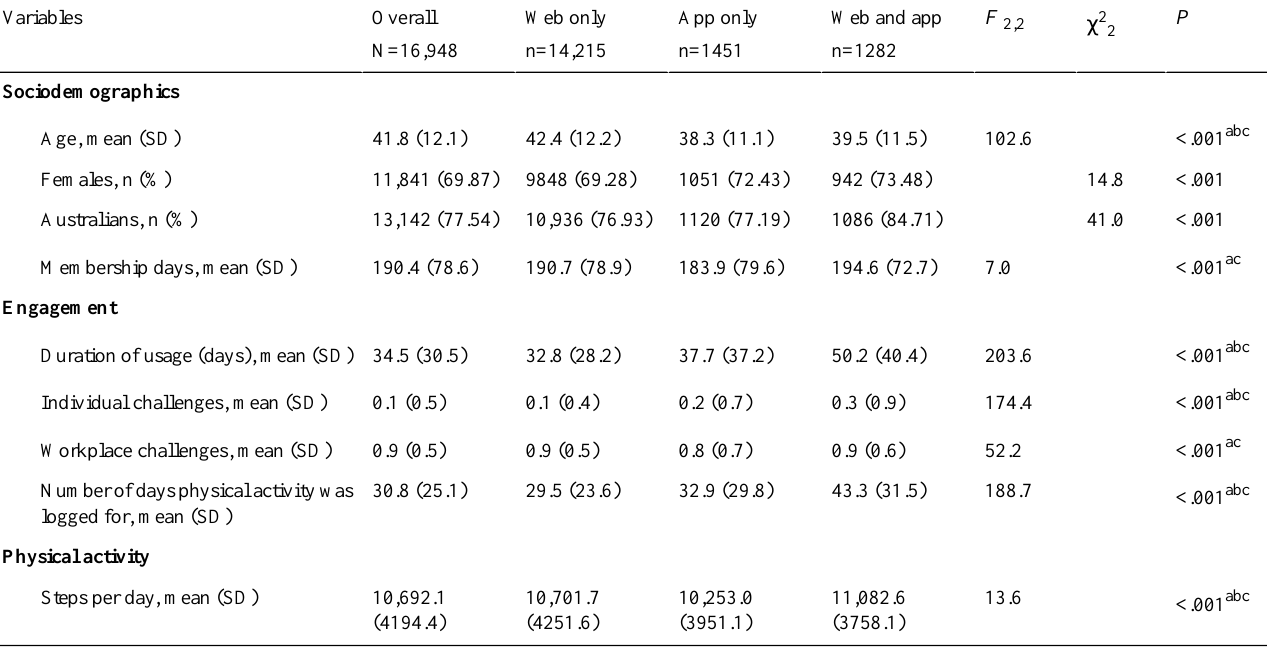
Table 1. Sociodemographics, engagement, and physical activity by user group in the overall sample